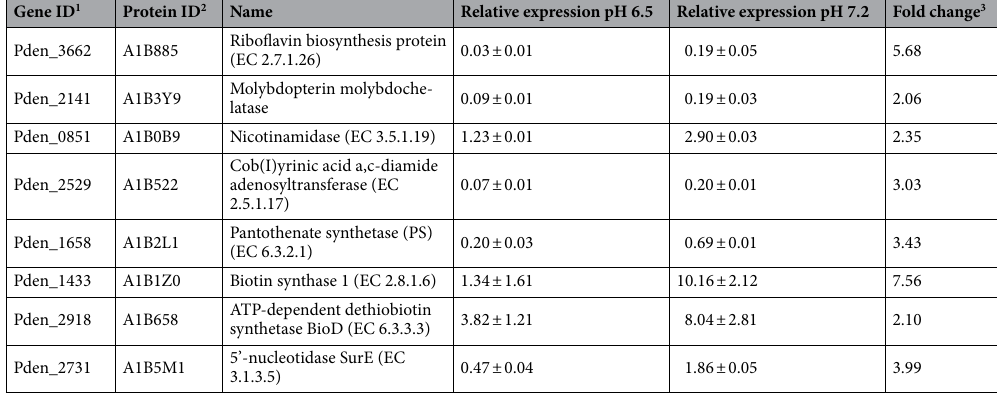
Table 2. Gene expresión analysis by qPCR of several genes involved in biosynthesis of cofactors in P. denitrificans PD1222. 1 Protein annotated from UniProt (UP000000361). 2 Genes annotated from GeneBank (T00440). 3 Fold change calculated as the ratio gene expression at pH 7.2 and pH 6.5 (using pH 7.2 as reference condition). The primers used are described in Table S5. Data are means ± SD of three independent biological replicates (n =